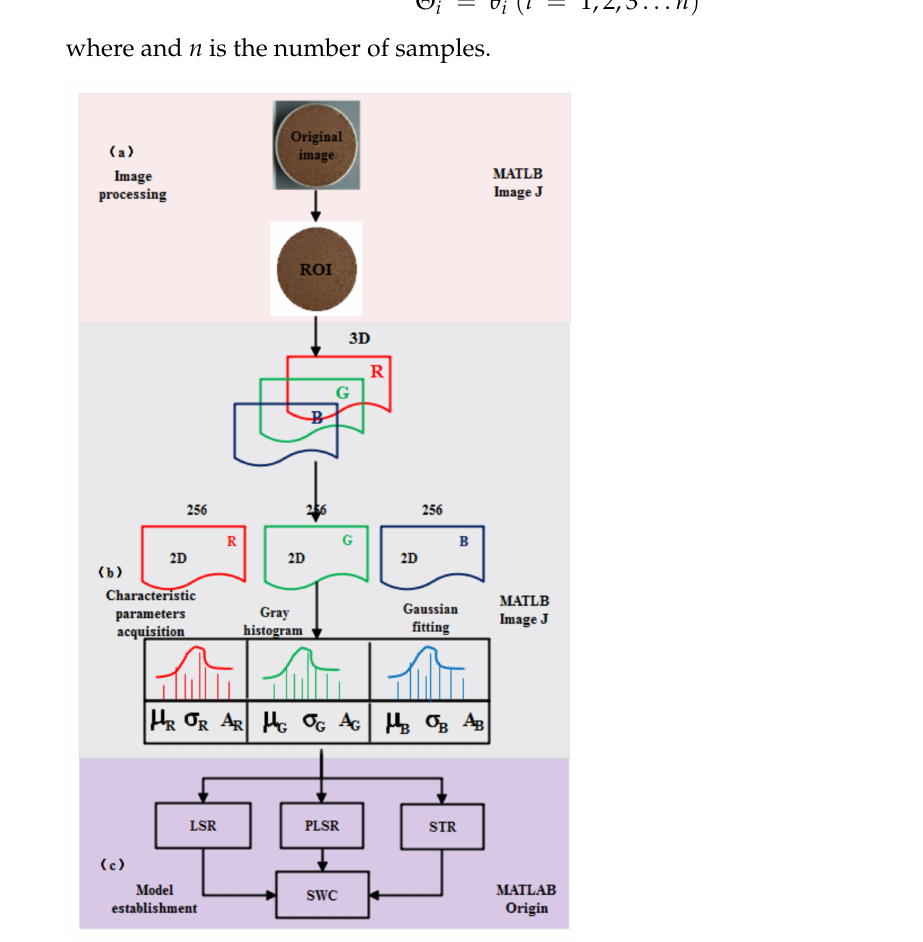
Figure 3. Flow chart: ( a ) image processing; ( b ) characteristic parameter acquisition; ( c ) model construction. The Gaussian fitting of RGB channels is shown in Figure 4, which shows that µ with statistical significance has the capacity to resist external disturbance than the mean value and the median value, and shows more representativeness. The curves of characteristic parameters from the RGB color space versus water content is shown in Figure 5, which also confirms a strong stability of the characteristic parameters. To distinguish the applicability of the 21 characteristic parameters to SWC prediction, the best prediction variables were screened by correlation